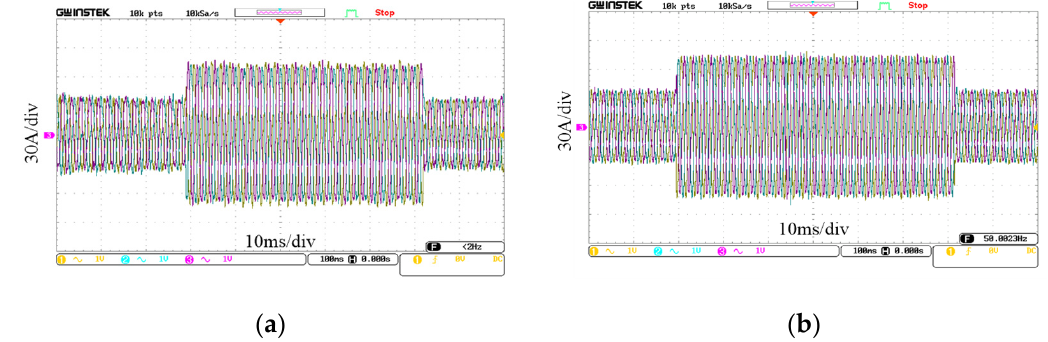
Figure 10. Experimental dynamic current waveforms: ( a ) Output current of the single closed-loop control experiment, ( b ) output current of the double closed-loop control experiment.